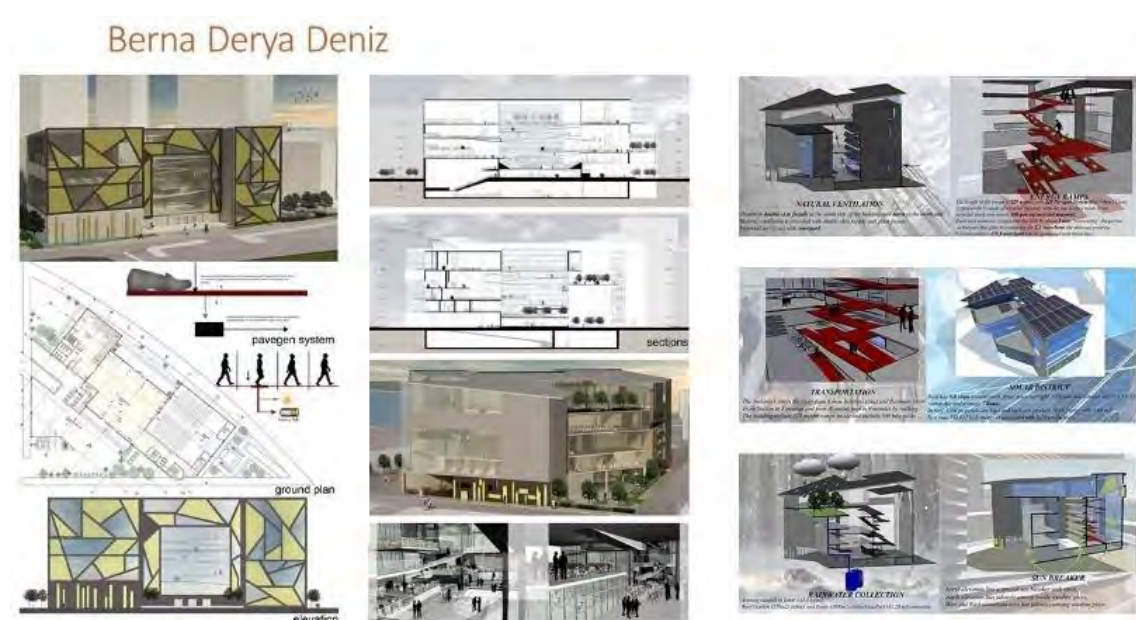
Figure 2. The designed Architecture school incorporate the use of; long ramps floors to convert kinetic energy to electricity, natural light, shading elements, natural ventilation, solar panels, green roof, rain water collection.